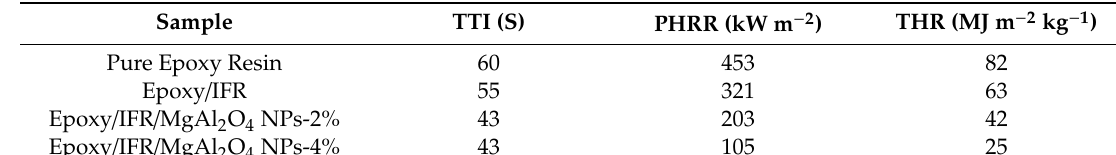
Figure 12. PHRR curves of coatings.